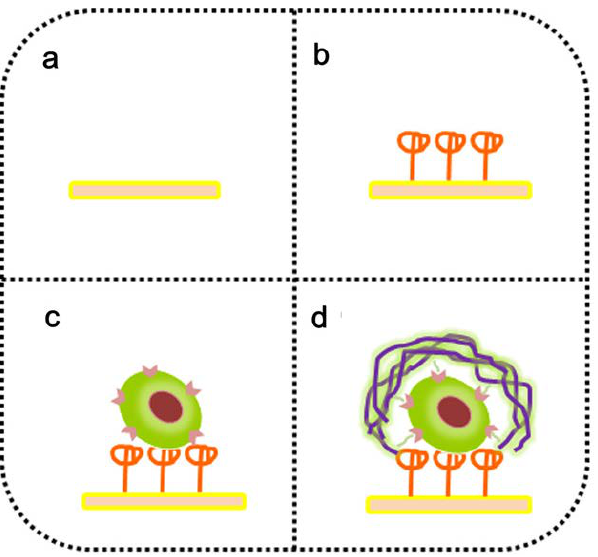
Figure 4. Diagram showing the stages of sensing CD44 on the surface of breast cancer stem cells as explored by Tang et al. (2019). ( a ) Bare gold electrode, ( b ) gold electrode with nucleolin AS1411, ( c ) attachment of breast cancer stem-like cell containing CD44, and ( d ) analyte-specific interaction between the functional groups of the multi-functionalized PNFs and the surface CD44 molecules. Reprinted (adapted) with permission from Anal. Chem. , 2019, 91, 7531–7537 [45]. Copyright 2019 American Chemical Society.